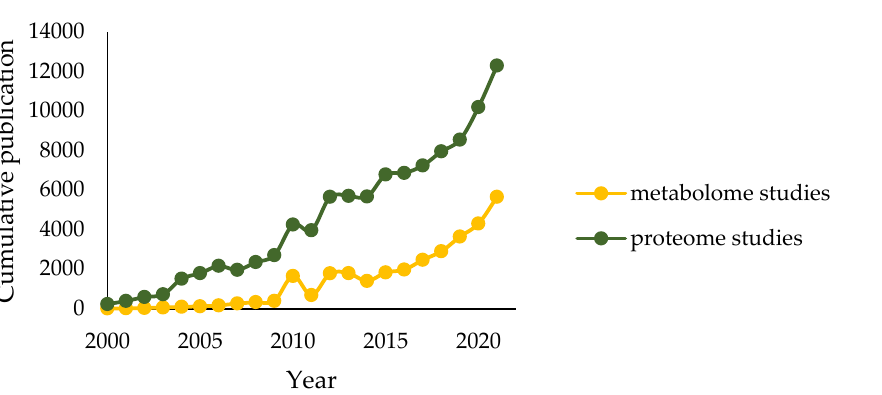
Figure 1. A comparison of research outputs for salivary proteomic and metabolomic studies. Data were gathered by searching Google Scholar for the terms “saliva” OR “salivary” AND “proteome” OR “proteomics” (green line) compared to “saliva” OR “salivary” AND “metabolome” OR “metabolomics” (yellow line) in article title fields .